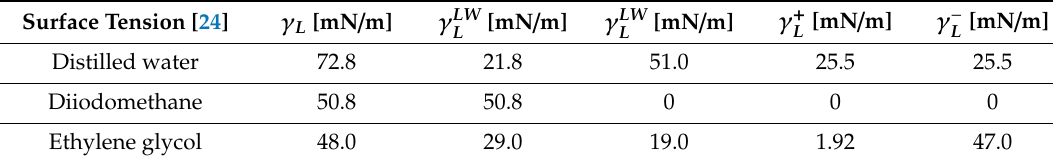
Table 2. The three selected liquids and their surface tension components.